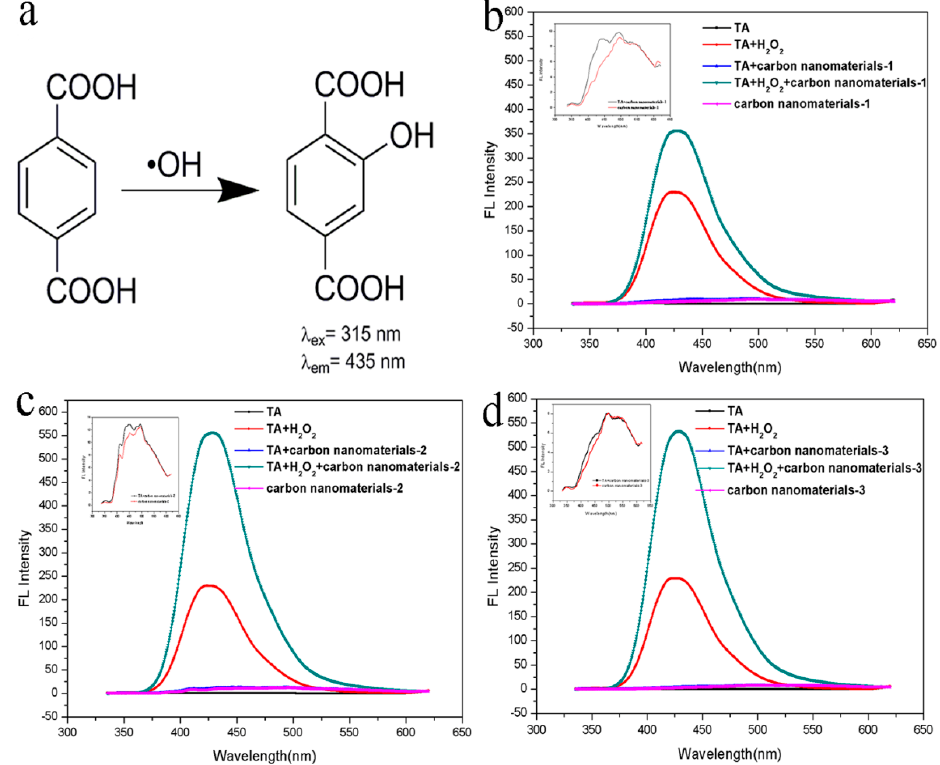
Figure 6. ( a ) Reaction between hydroxyl radica • OH and terephthalic acid (TA). Fluorescence spectra of TA with/without H 2 O 2 treated 24 h with carbon nanomaterials; ( b ) Carbon nanomaterials-1; ( c ) Carbon nanomaterials-2; ( d ) Carbon nanomaterials-3. In the reaction system, the TA, H 2 O 2 and carbon nanomaterials were 0.5 mM, 1 mM, and 20 µ g · mL − 1 , respectively. The fluorescence spectra were acquired with a LS55 fluorescence spectrometer (PerkinElmer, Waltham, MA, USA).